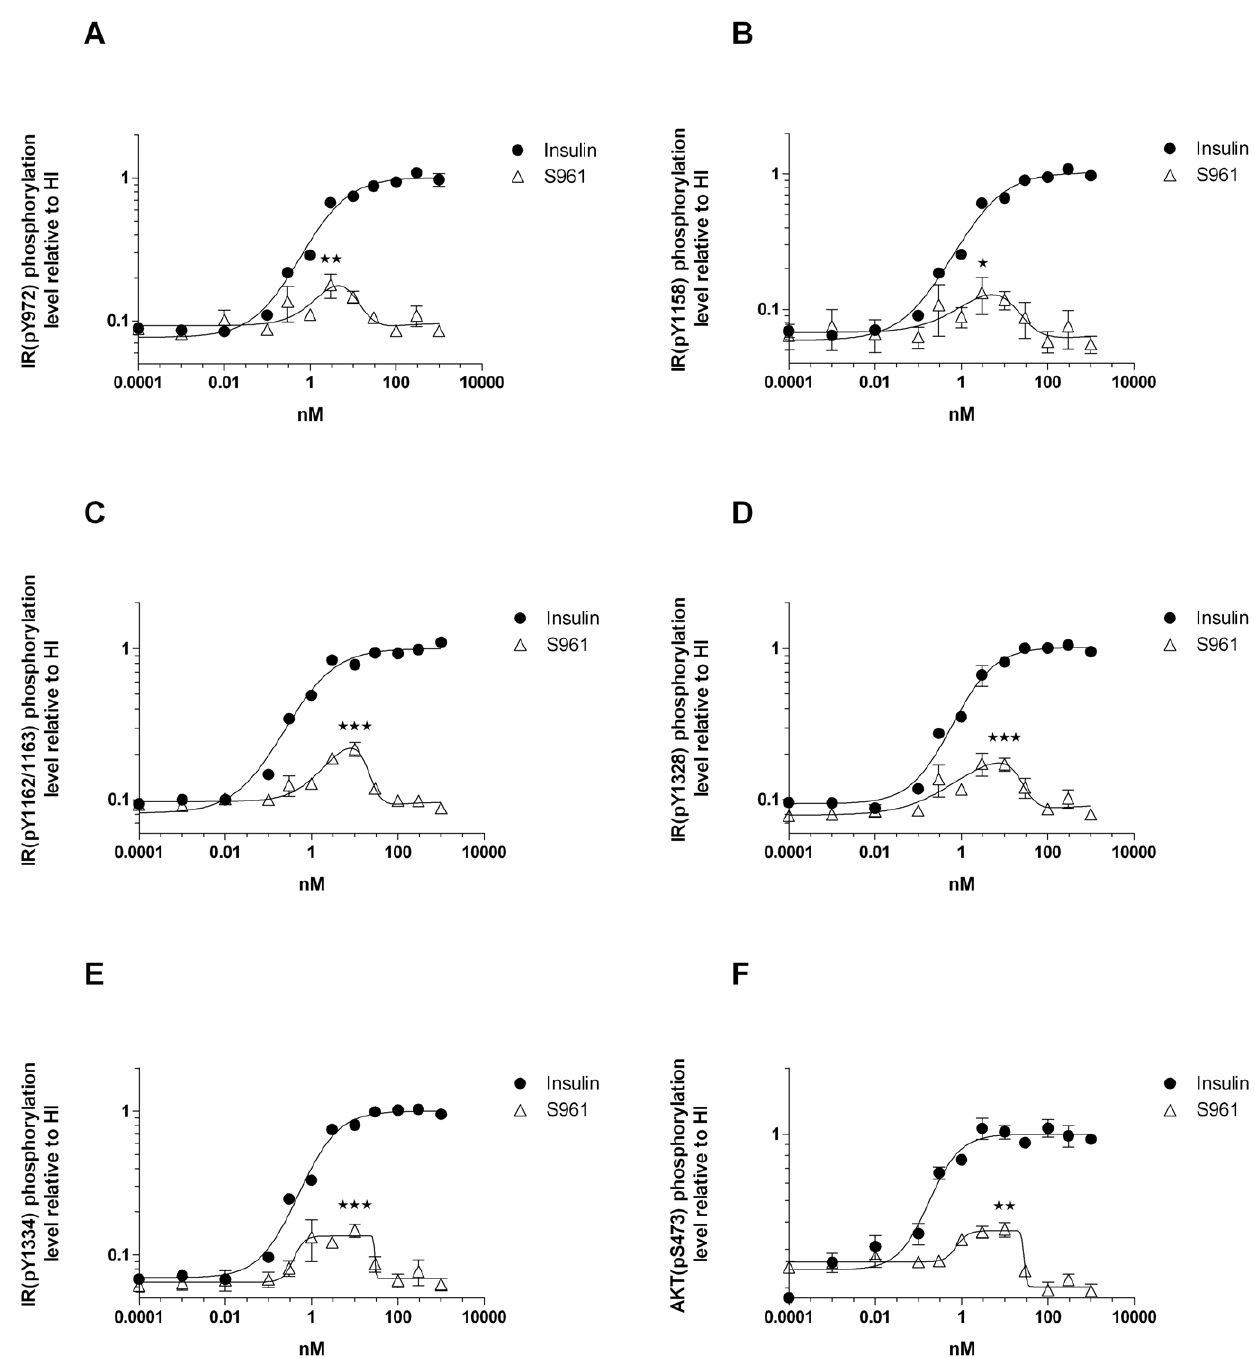
Figure 3. S961 stimulates IR and Akt phosphorylation in CHO-hIR cells. Cells were stimulated with increasing concentrations of HI or S961. A - E , IR tyrosine phosphorylation. The 6 tyrosine phosphorylation sites which were examined were Y972 in the juxtamembrane domain, Y1158 and Y1162/1163 in the tyrosine kinase domain, and Y1328 and Y1334 in the C-terminal tail end of the IR. F , Akt phosphorylation. Phosphorylation of Ser437 is known to be required for Akt activation. Panels A - E : the increased tyrosine phosphorylation of the IR was significant (compared to 0.0001 nM, 0.001 nM and 0.01 nM S961, P , 0.05*, P , 0.01**, P , 0.001***, two-tailed t-test). Panel F : the increased serine phosphorylation of Akt was significant (compared to 0.0001 nM, 0.001 nM and 0.01 nM S961, P , 0.01**, two-tailed t-test). Data points represent average of three independent experiments, each comprising triplicate determinations. Error bars show one standard deviation. doi:10.1371/journal.pone.0051972.g003 combination with HI in L6-hIR cells (Fig. 4B). As expected, HI S961 which did not induce glycogen synthesis in differentiated and IGF-I were strong and very weak stimulators, respectively, of adipocytes (Fig. 4A). Similarly, neither S961 nor S661 were able to glycogen synthesis in differentiated 3T3-L1 cells in contrast to stimulate glycogen synthesis in L6-hIR cells (Fig. 4B). In addition,